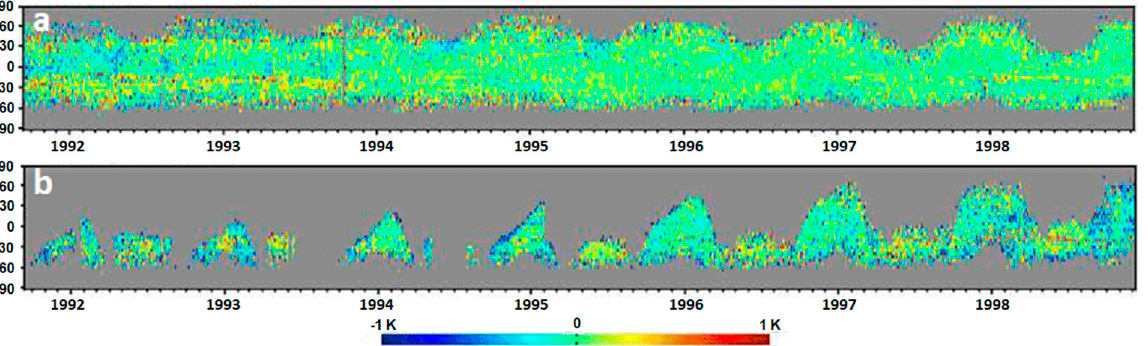
Figure 10. Hovmöller diagrams (latitude vs. time) of nighttime N12 − (D + TM) SST ( a ) RAN2 ‘subskin’, ( b ) CCI ‘skin’ + 0.17 K. (Note that PF did not process N12.) (Data are from the NOAA SQUAM system [21,22]).